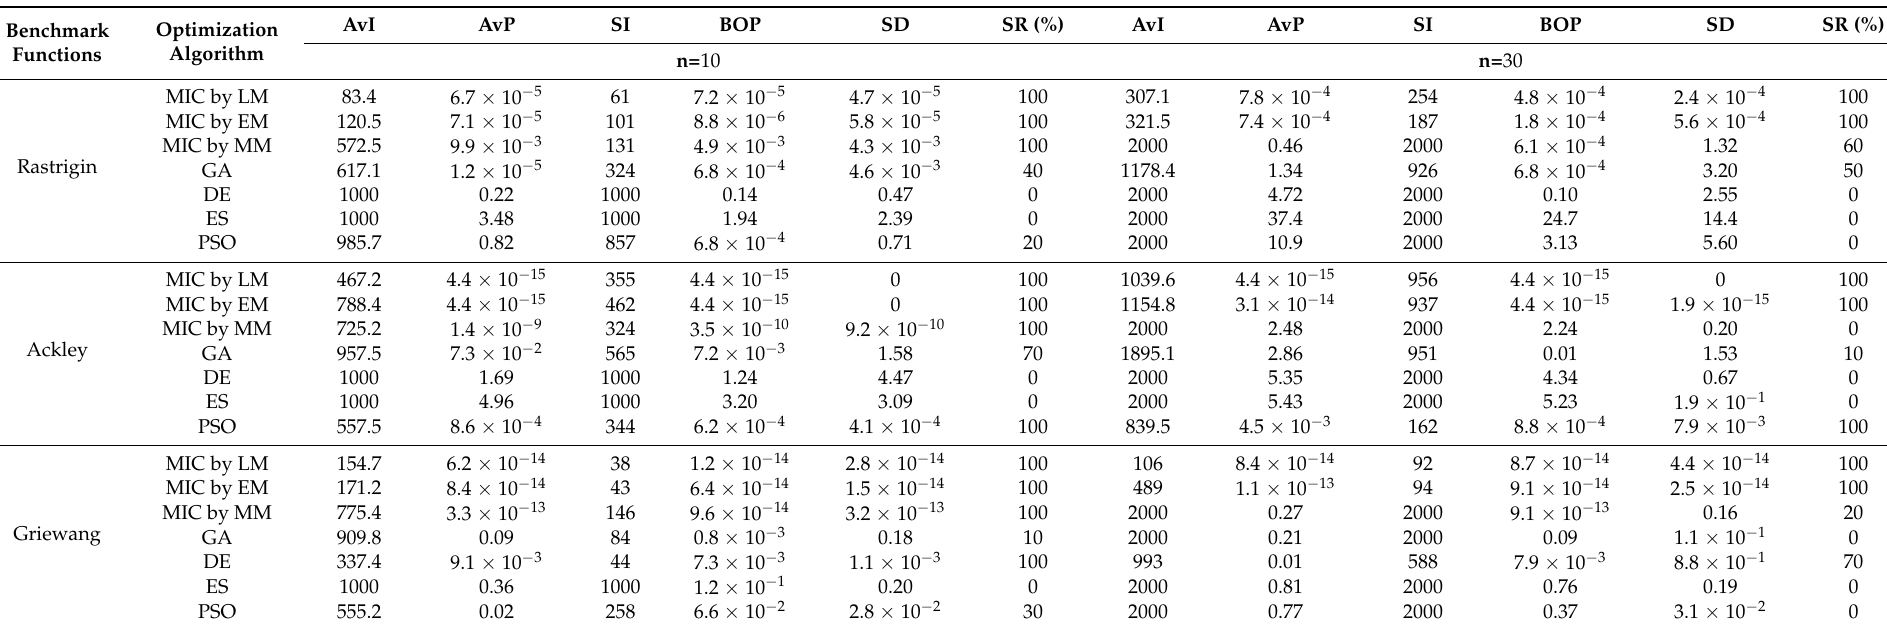
Table 3. The Results of MIC Compared with Traditional GA, DE, PSO, and ES in Three Benchmark Functions (10D and